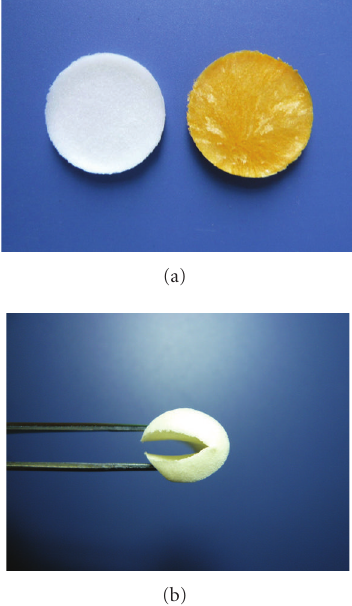
Figure 1: Photograph of chitosan-alginate sponge (C2A2). (a) Appearance ( left, pure sponge; right, sponge with curcumin), (b) sponge showing the pliability of the freeze dried material.